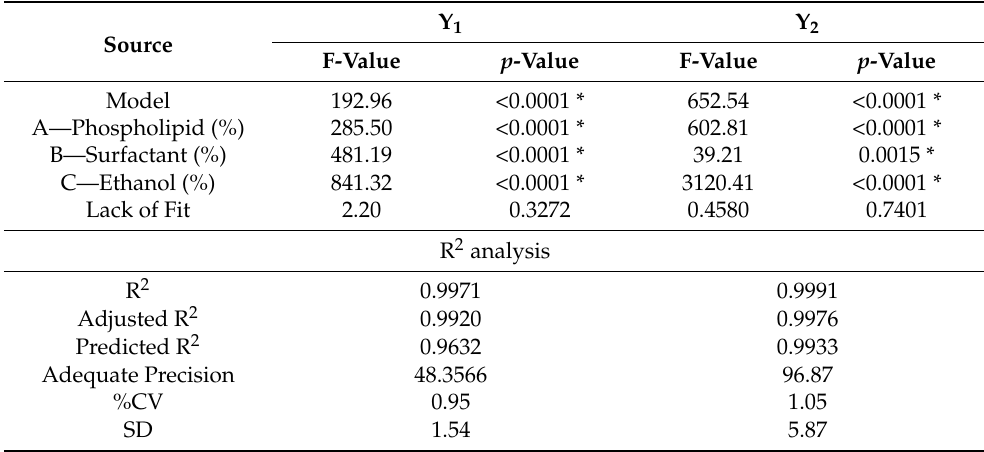
Table 2. Regression analysis results using ANOVA for independent responses Y 1 and Y 2 using quadratic model